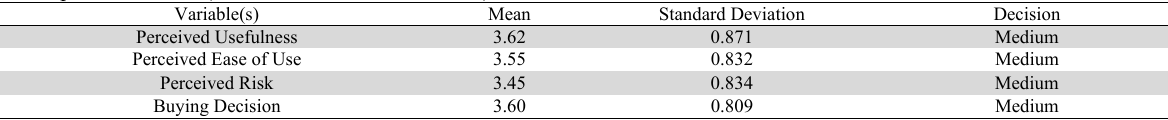
Descriptive Statistics (mean and standard